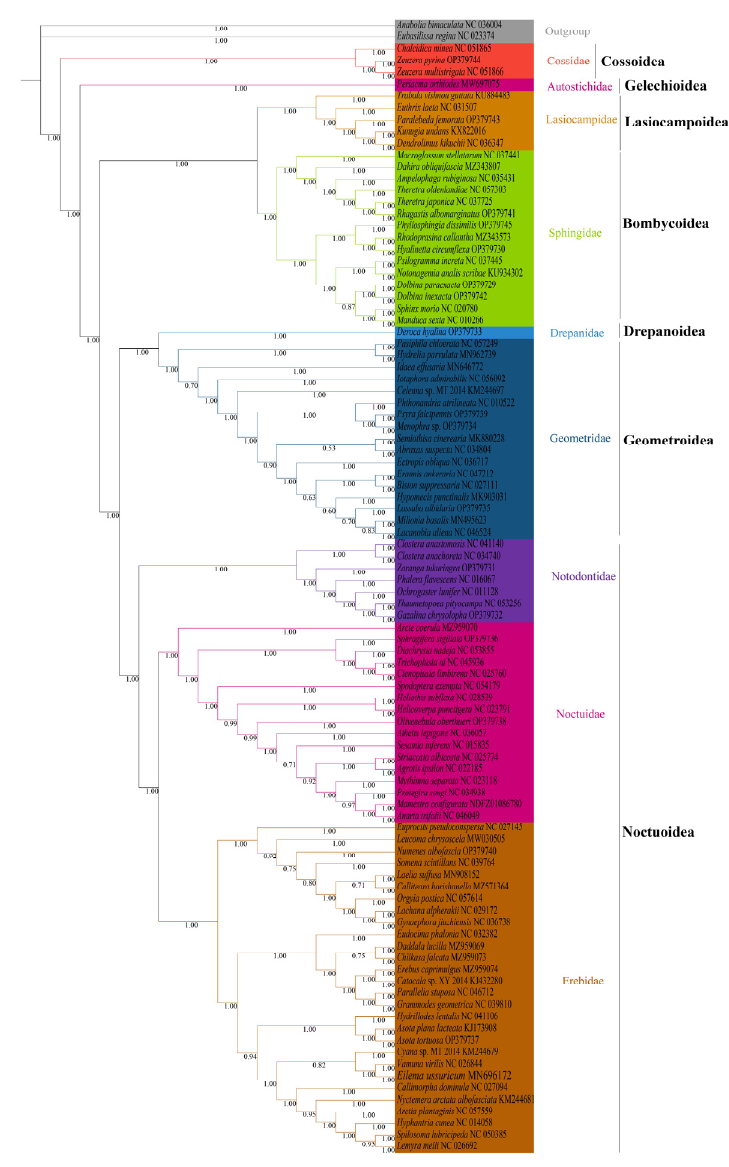
Figure 7. Phylogenetic tree inferred from DNA sequences of 13 PCGs using Bayesian inference (BI) analysis. The number on the branches indicates Bayesian posterior probabilities.